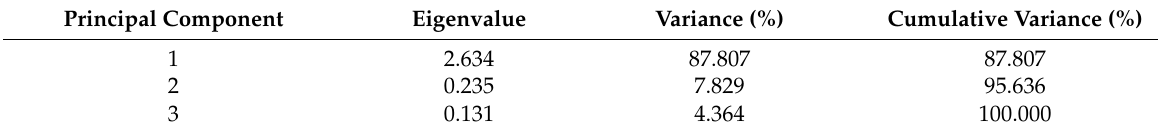
Table 4. Principal component analysis (PCA) of the tree-ring width chronologies from three age-classes of Schrenk spruce trees in the eastern Tianshan